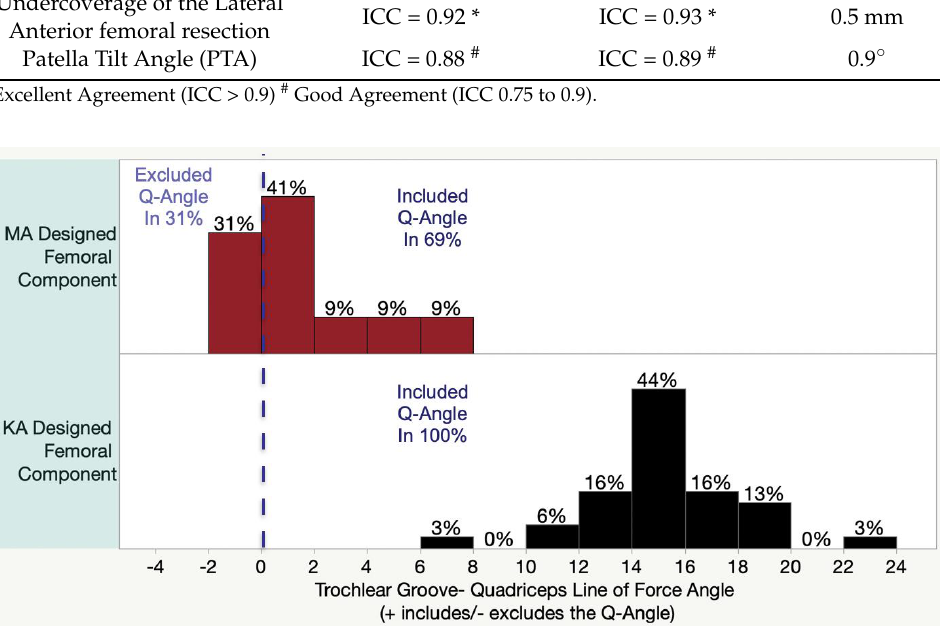
Figure 5. Histograms show the inclusion or exclusion of the patient’s Q -angle for both MA D - and KA D -FC. The KA D -FC’s 2 ± 1.8 mm lateral undercoverage of the anterior femoral resection was 2.4 mm less than the 4.4 ± 1.5 mm for the MA D -FC ( p < 0.001) (Figure 6).